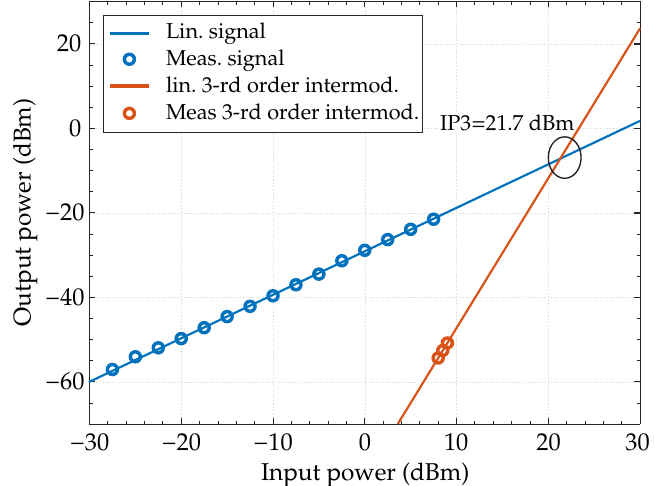
Figure 6. Intermodulation characterization: estimated input IP3 at V r = 10V for two Eu-DSRC carriers at 5.795 and 5.805 GHz.